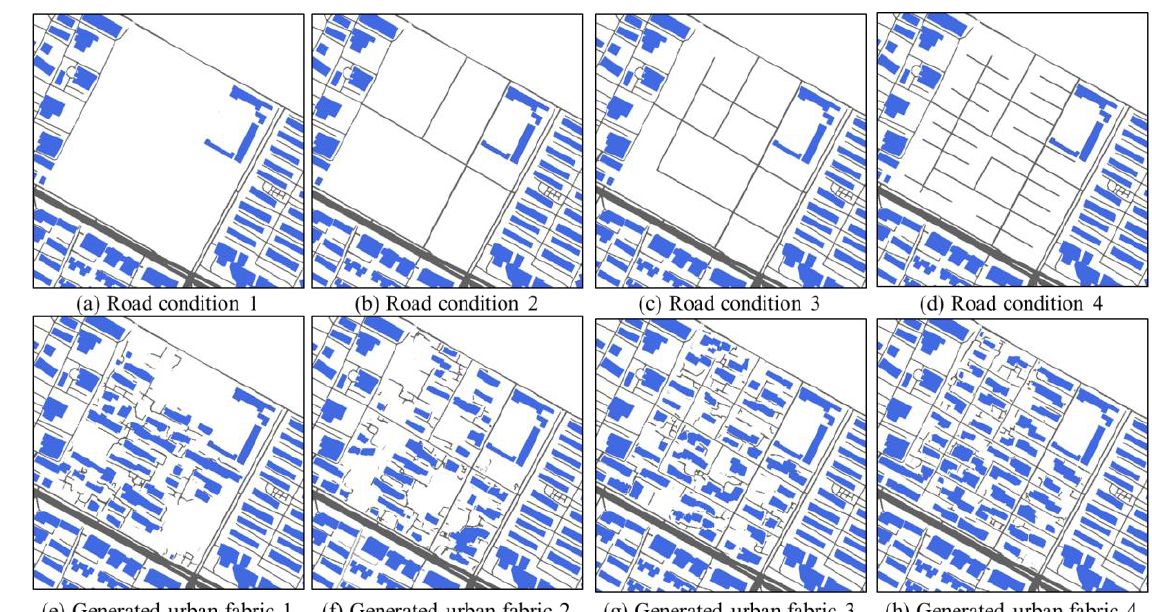
Figure 6. Initial road networks and generated urban fabric